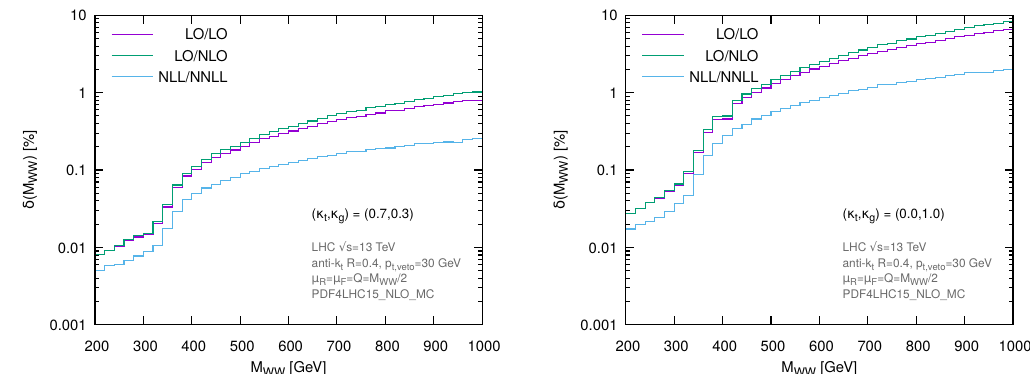
Figure 4 . The relative di(cid:11)erence between BSM and SM d(cid:27)=dM WW de(cid:12)ned in eq. (4.4) for the two benchmark scenarios ( (cid:20) t ; (cid:20) g ) BSM (left) and ( (cid:20) t ; (cid:20) g ) BSM (right). The labels refer to the accuracy 1 2 employed in the calculation of numerator and denominator in eq.